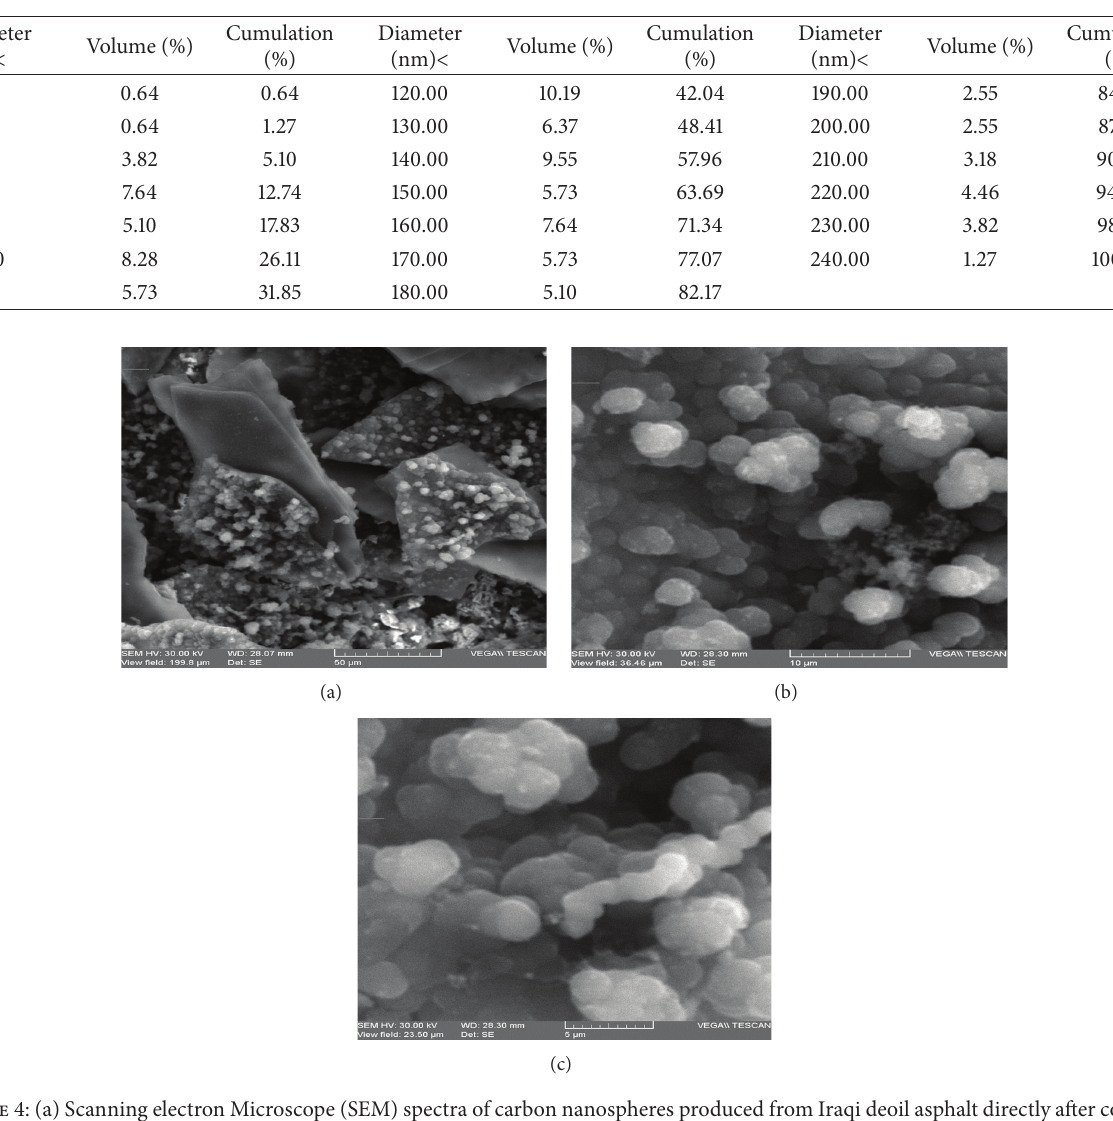
Table 2: Granular cumulation distribution of CNS.